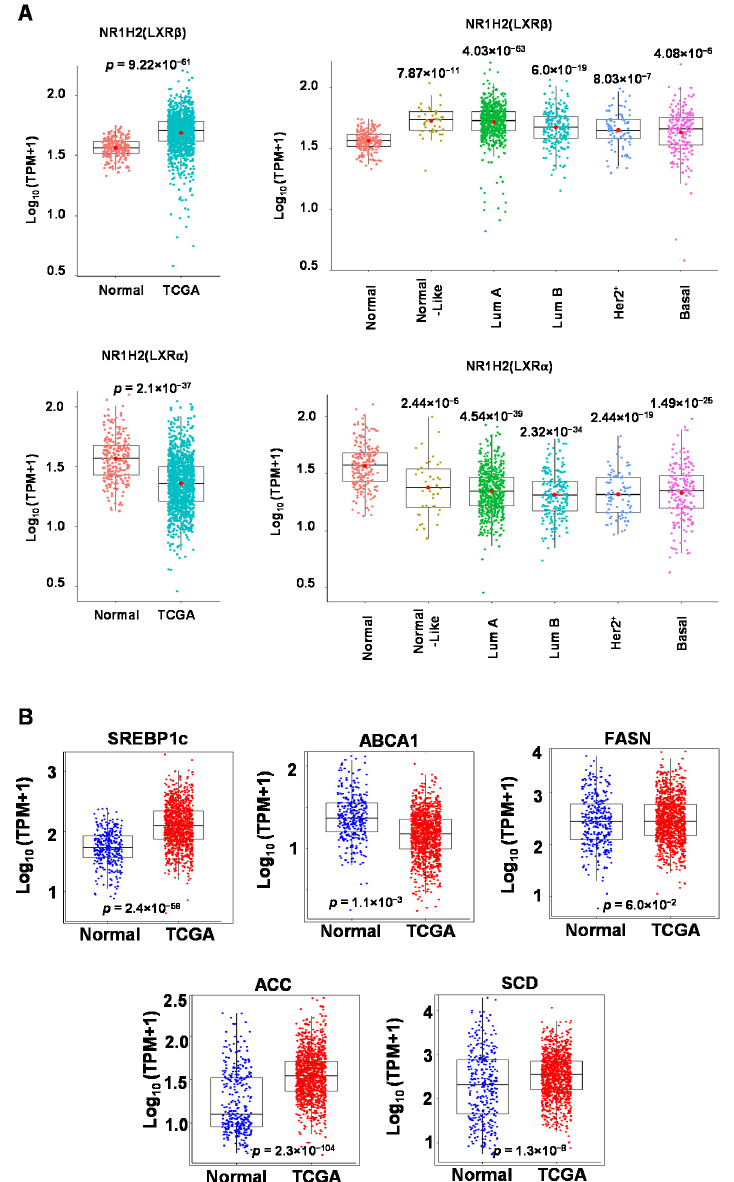
Figure 1. LXR β and LXR target genes are overexpressed in breast tumors. ( A ) LXR α and LXR β transcript levels were examined in the TCGA dataset and compared to their expression in GTEx normal breast tissues. Gene expression levels were also compared between breast cancer subtypes (normal-like, luminal A, luminal B, HER2+, and basal-like) and normal breast tissues. ( B ) Known LXR target genes SREBP1c, ABCA1, ACC, SCD, and FASN expression levels were similarly analyzed. Welch’s two-sample T-test was used for all statistical analyses. Three breast cancer cell lines (MCF-7, MCF-7-TamR, and MDA-MB-231) were se- lected to determine the effects of modulating LXR activity with 1E5 in different types of breast cancers. MCF-7 and MCF-7-TamR are both hormone receptor-positive luminal A